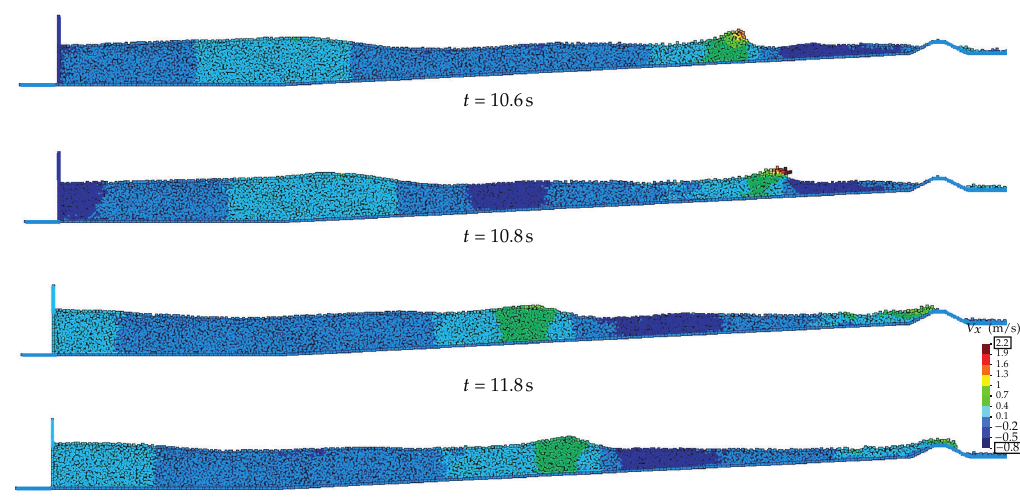
Figure 9: Horizontal velocities (cid:2) m/s (cid:3) along the flume for the case with a still water level of